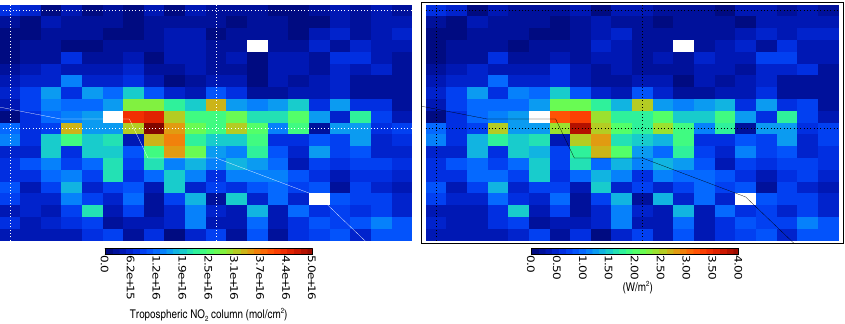
Fig. 9. Diurnal variations in tropospheric NO 2 columns (thin lines) and NAH (thick lines) for the Northeastern US (left) and African regions (right). Diamonds: OMI-derived NO 2 column; solid lines: correspond to simulated diurnal variations in NO x emissions (see text for details); dashed lines: correspond to constant NO x emissions; dot-dash line: NAH computed for a constant NO 2 column corresponding to the OMI derived value.